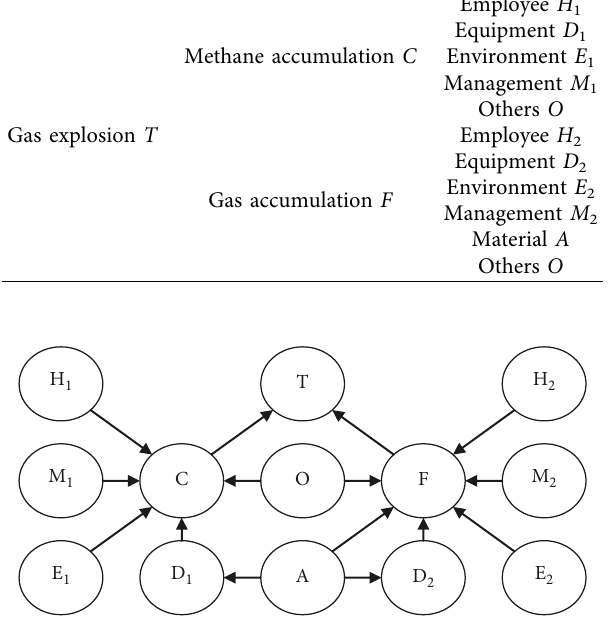
Figure 2: Initial model diagram of gas